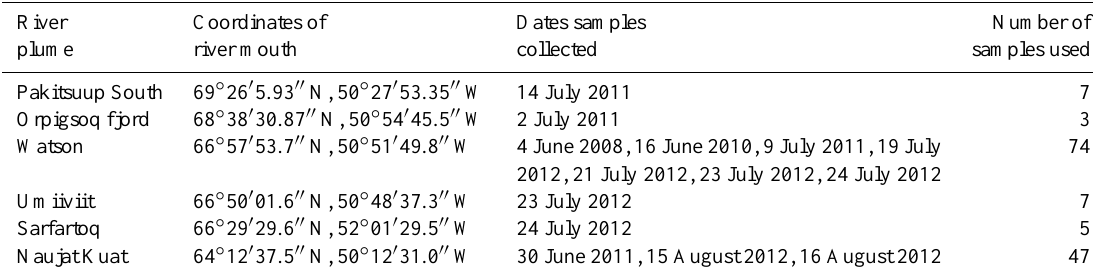
Table 2. Surface water samples used in retrival algorithm. River Coordinates of Dates samples Number of plume river mouth collected samples used